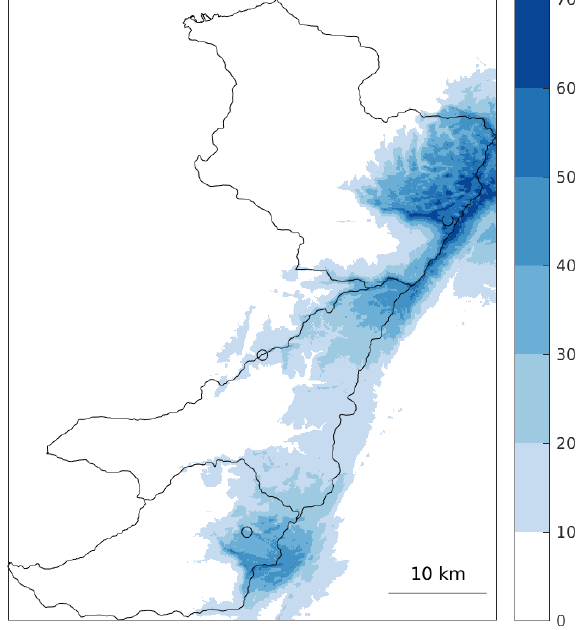
Figure 13. Mean annual snow sublimation in millimeters (Pflug et al., 2019